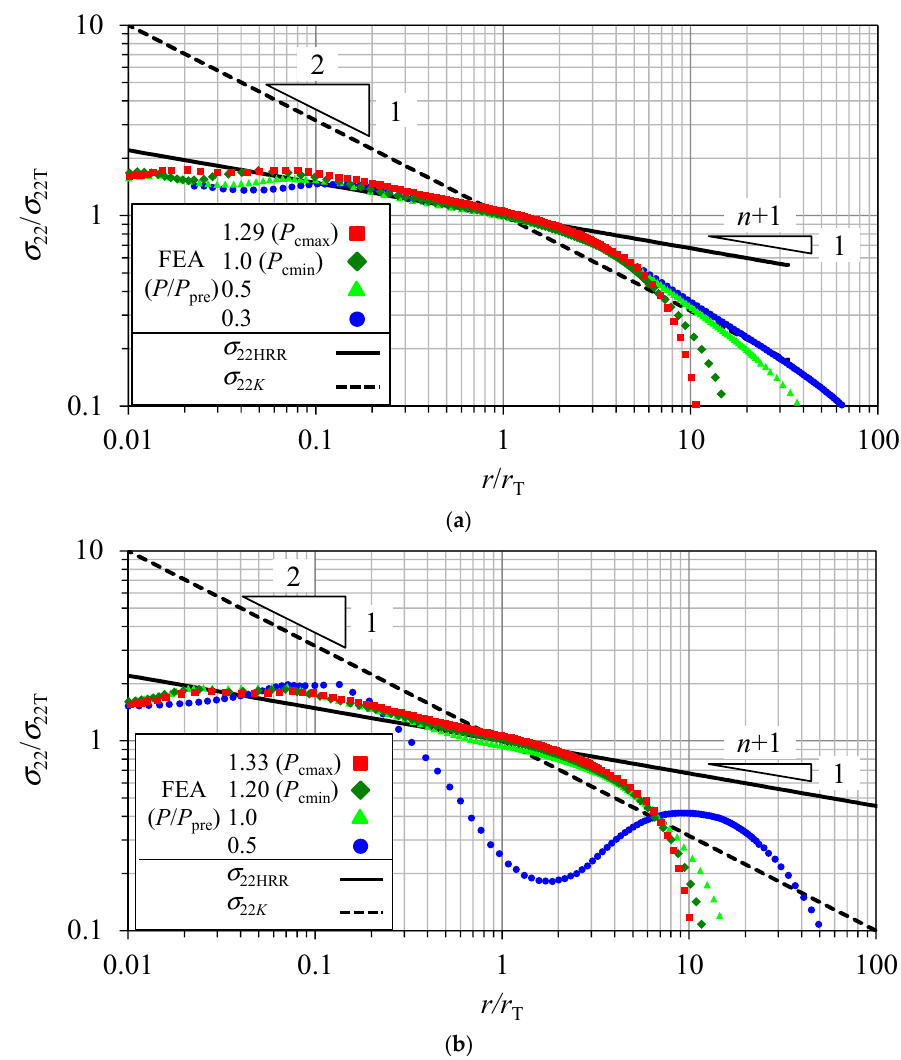
Figure 14. Comparison of T-scaled midplane crack-opening stress distribution ( a ) without and ( b ) with CRS for S45C SE(B) specimen at − 10 °C. Here, P pre is the preload for applying CRS, P cmin and P cmax are the minimum and maximum fracture loads observed in experiments, respectively. P cT is the predicted fracture load obtained using the proposed method.